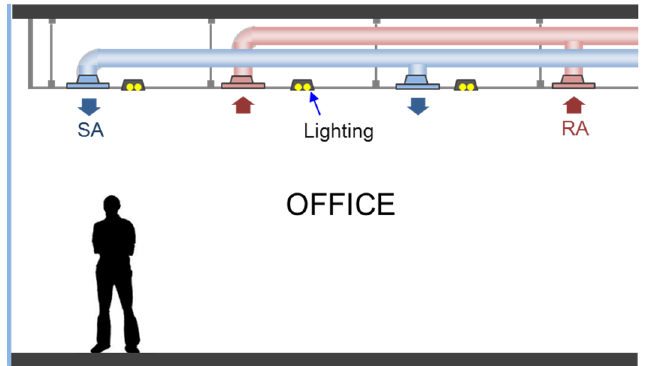
Figure 2. Ceiling-based air distribution system concept.